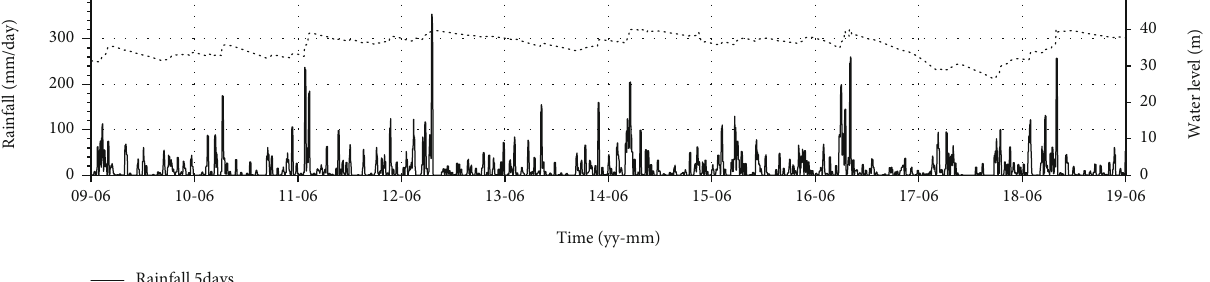
Figure 5: Water level and antecedent 5-day rainfall.